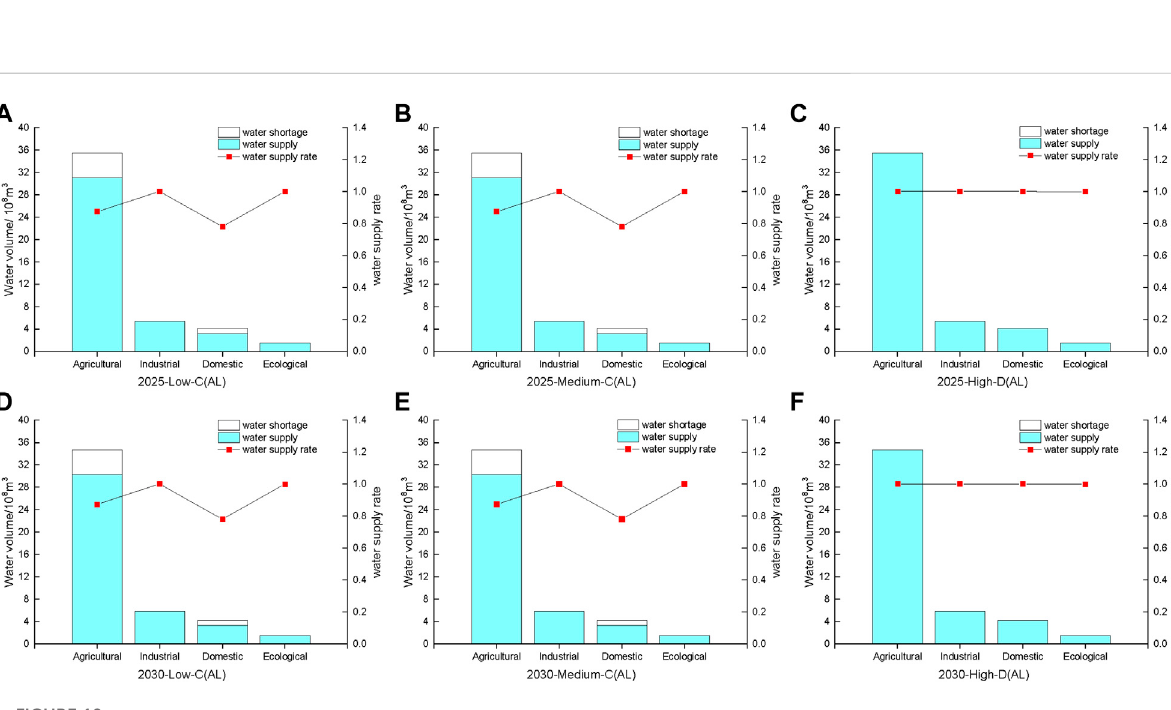
Frontiers in Earth